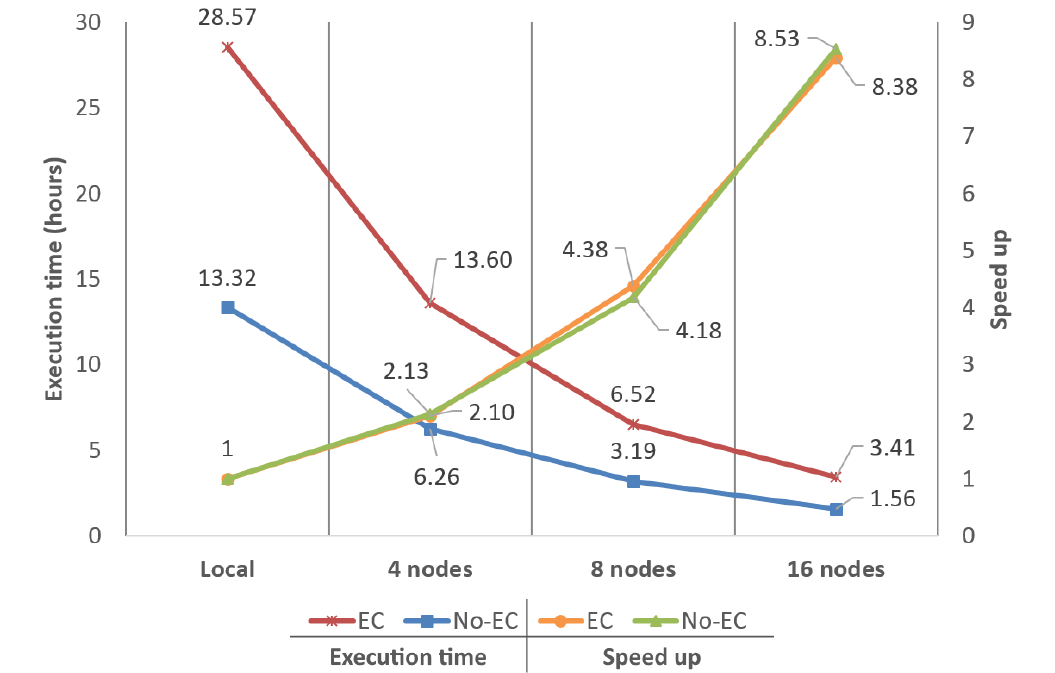
Figure 7. Performance analysis and scalability comparison using dataset D1 (400 ×